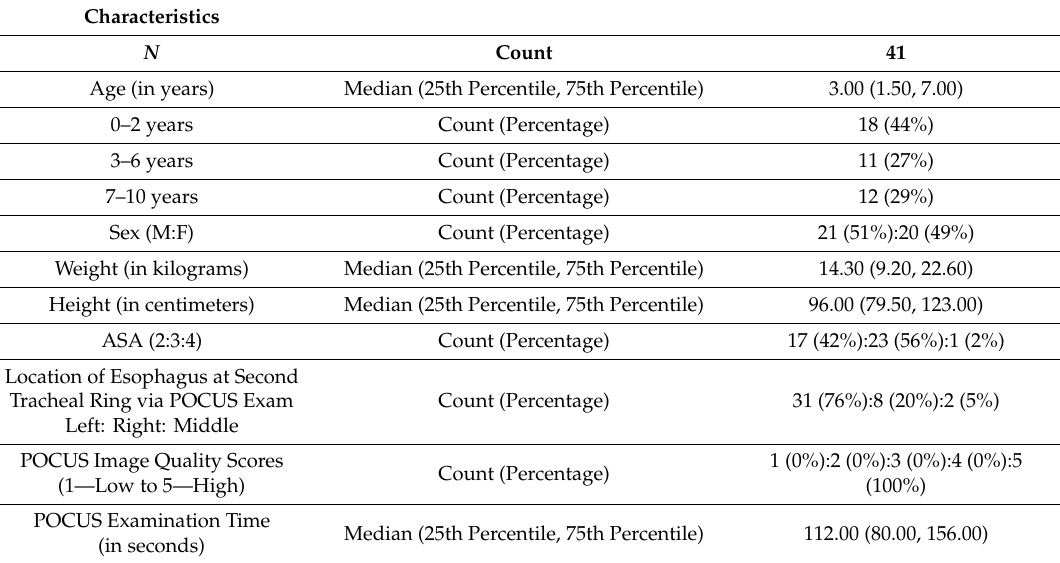
Table 1. Study characteristics: chest fluoroscopy to ultrasound.